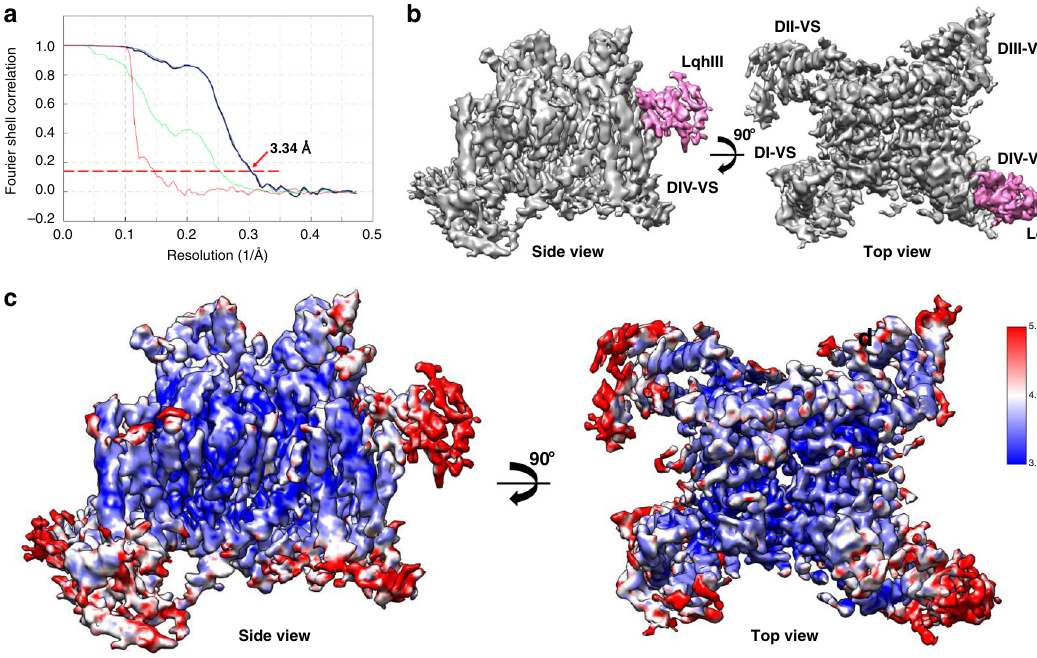
Fig. 2 Cryo-EM structure of the rNaV1.5 C /LqhIII complex. a The FSC between independently re fi ned half-maps for rNa v 1.5 C /LqhIII reconstruction. b Overall cryo-EM reconstruction (side view, left; top view, right) of the rNa V 1.5 C /LqhIII complex. Na V 1.5 C and LqhIII colored in grey and purple, respectively. c Local resolution (side view, left; top view, right) of the EM map colored from blue to red representing resolution from high to low (sidebar).